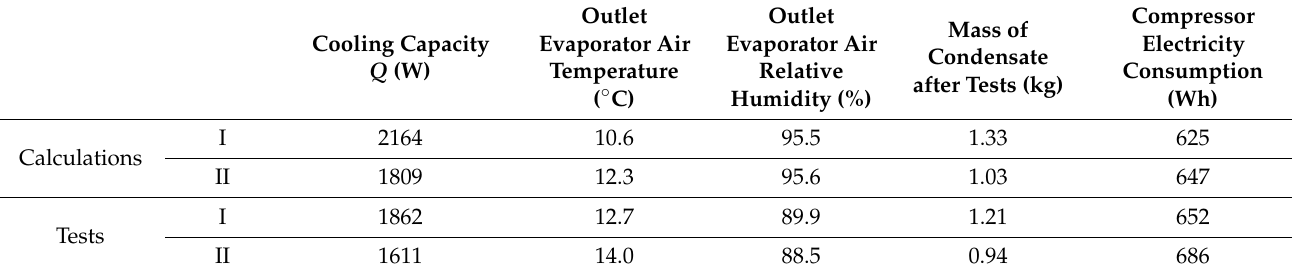
Table 6. Summary of calculations and